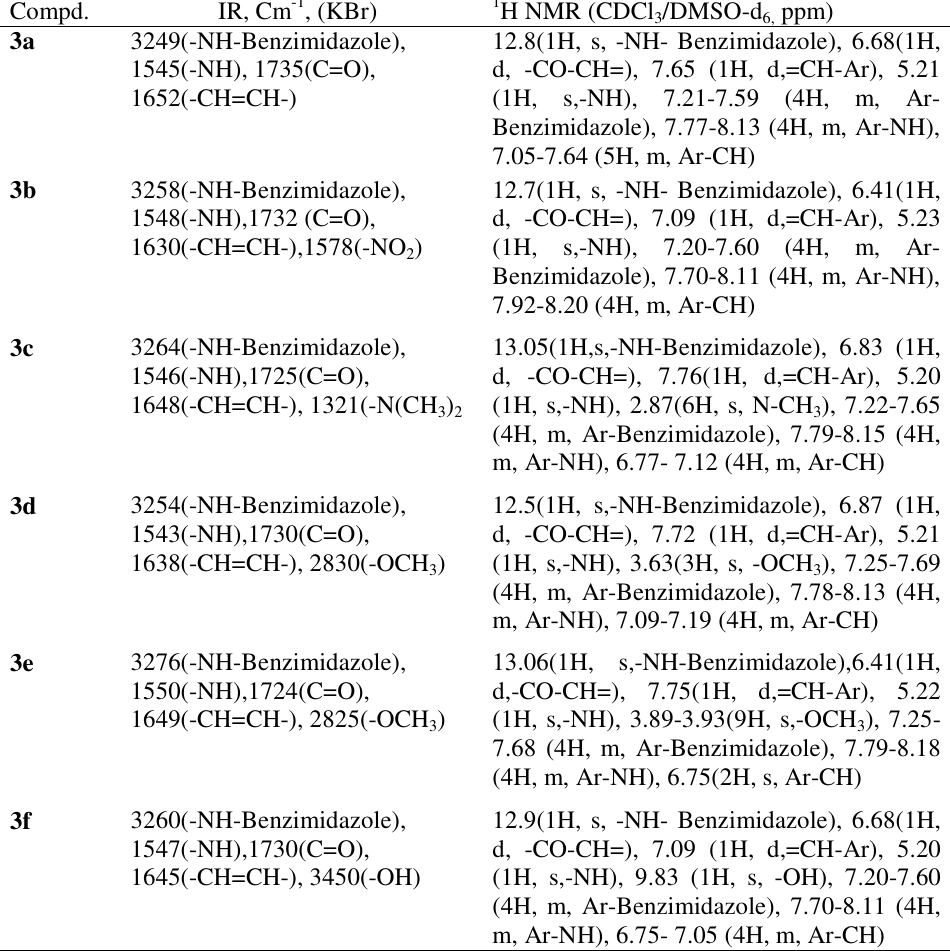
Table 2. Spectral data of the compounds